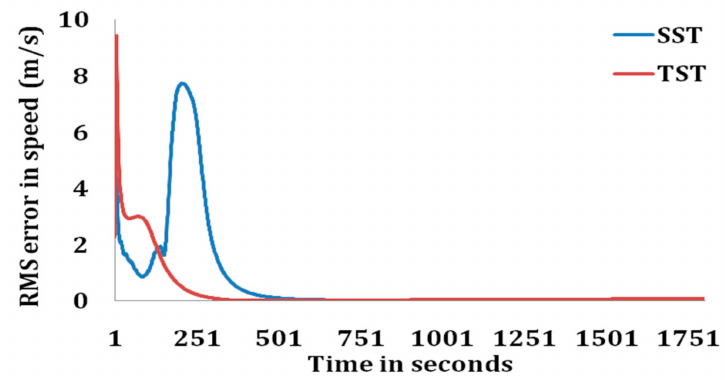
Figure 7. RMS error in speed estimates of the target with SST and TST.